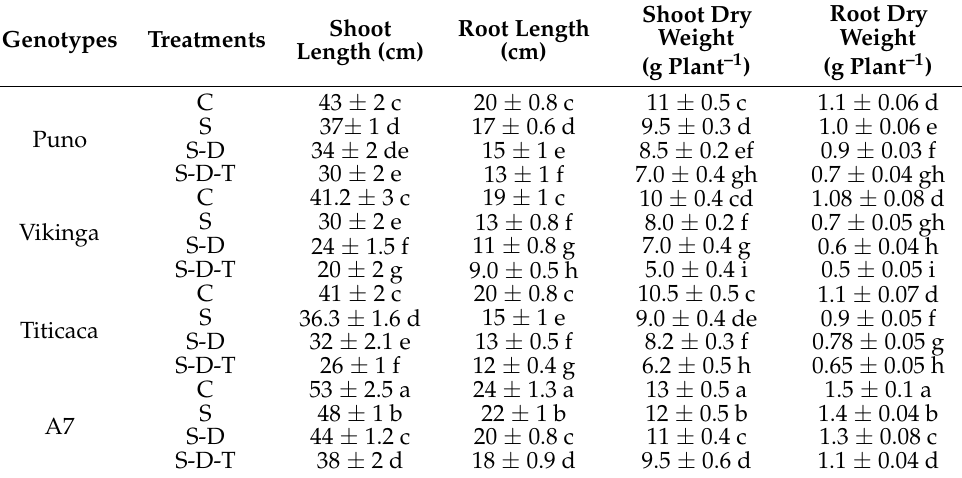
Table 1. Effect of salinity (S), drought (D), and temperature stress (T) on plant growth attributes of quinoa genotypes.